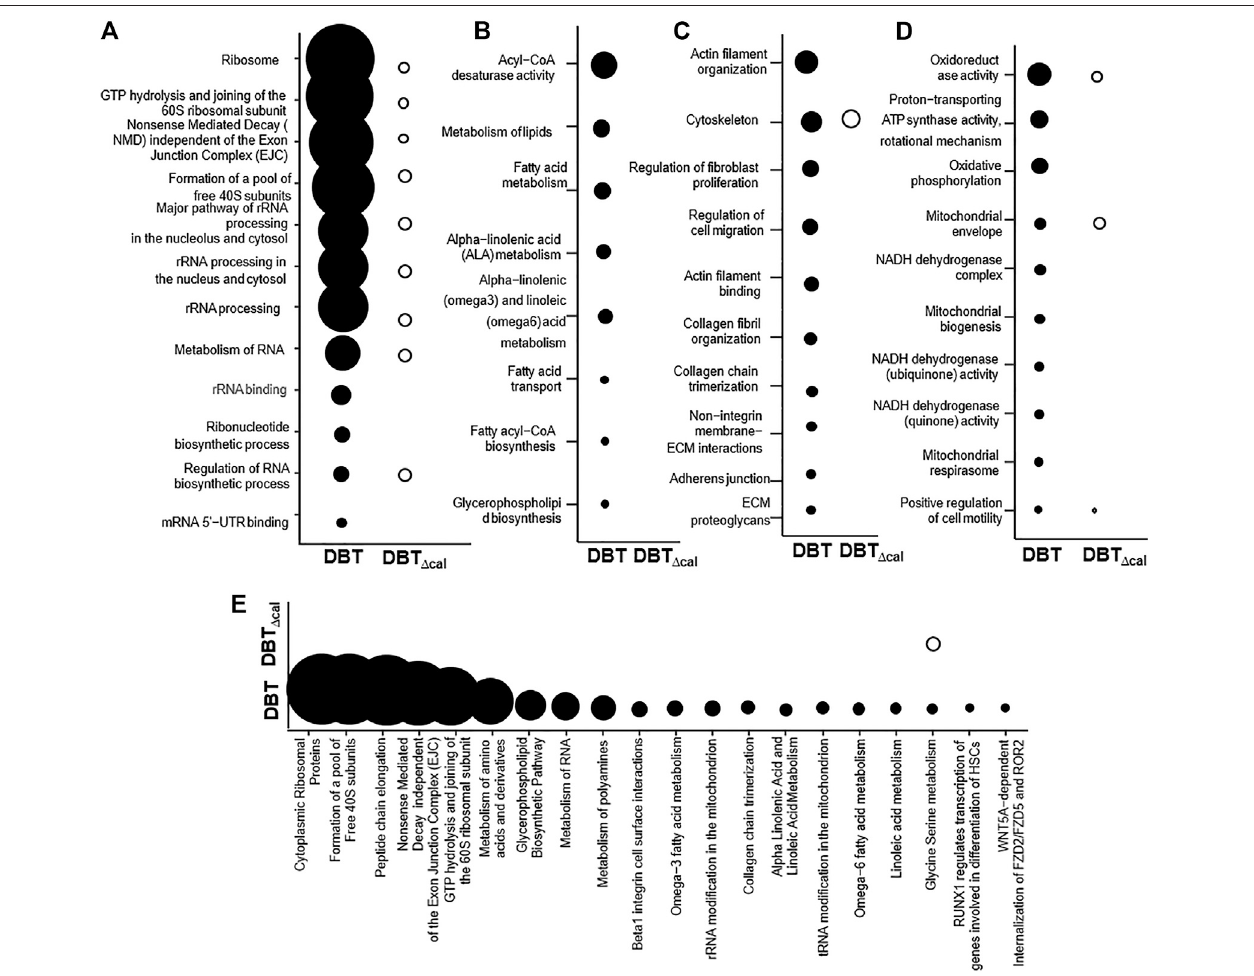
FIGURE 6 | Comparison of integrated omics between DBT and DBT Δ cal . The treatment of osteoblasts was as that in Figure 1 . The transcriptomics, proteomics, andlipidomicdatawereused. (A – D): KOBASanalysisenrichesthesignalingpathwayinDEGsandDEPsviaKEGG,Reactome,BioCye,PANTHERandGO. (E): IMPaLA analysis enriches the signaling pathway in DEPs and DEMs via KEGG. The size of the circle represents – log 10 (P).